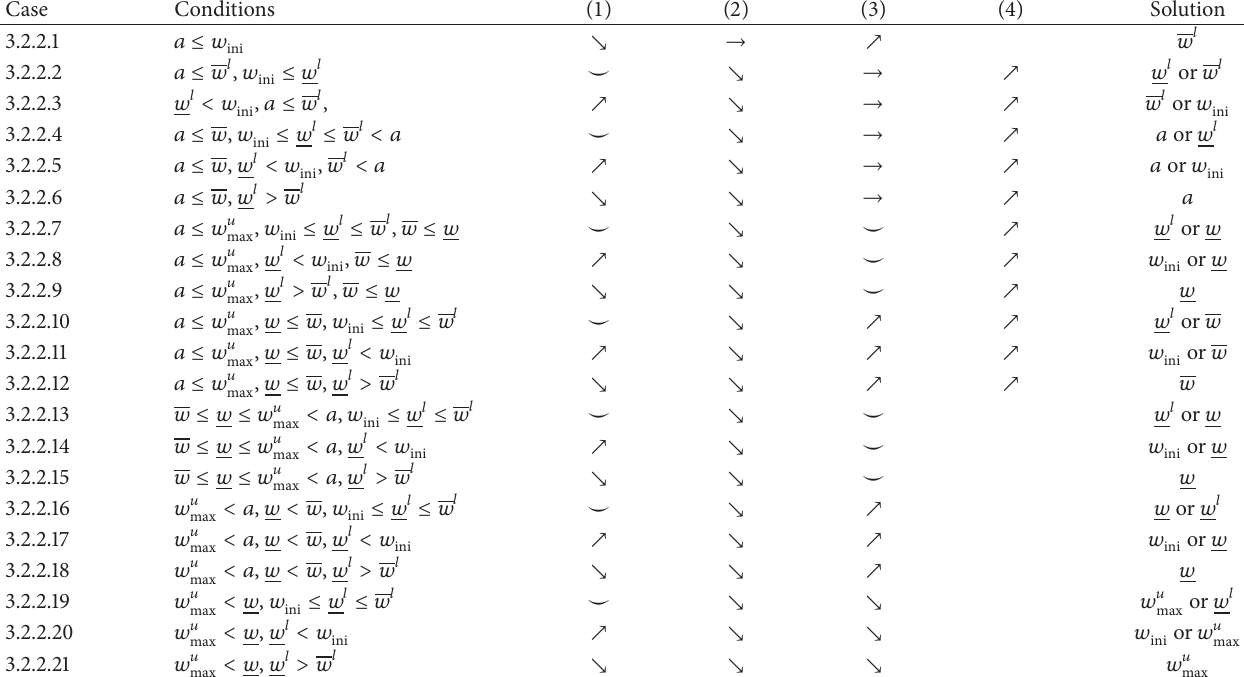
Table 11: Case 3.2.2 .